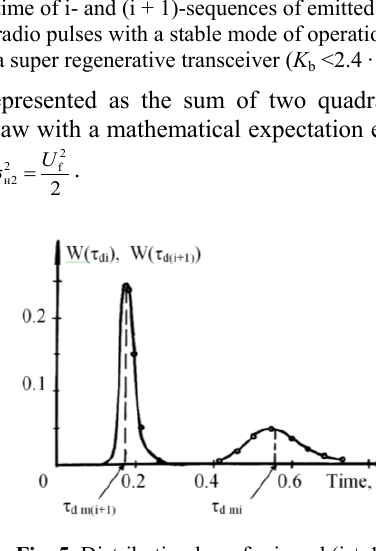
Fig. 5. Distribution laws for i- and (i + 1)- sequences of radio pulses of a super- regenerative transceiver in an unstable mode of operation ( K b = 3.6∙10 5